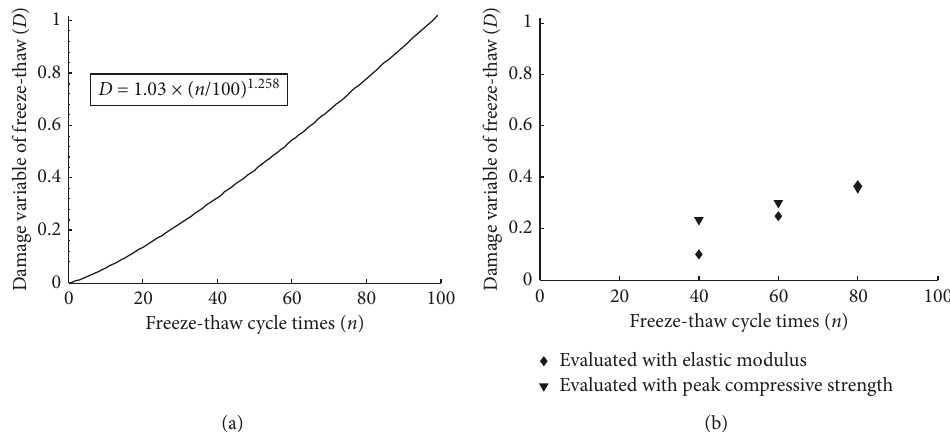
Figure 3: Damage variable versus freeze-thaw cyclic times: (a) experiment results; (b) comparison between two methods based on [20].